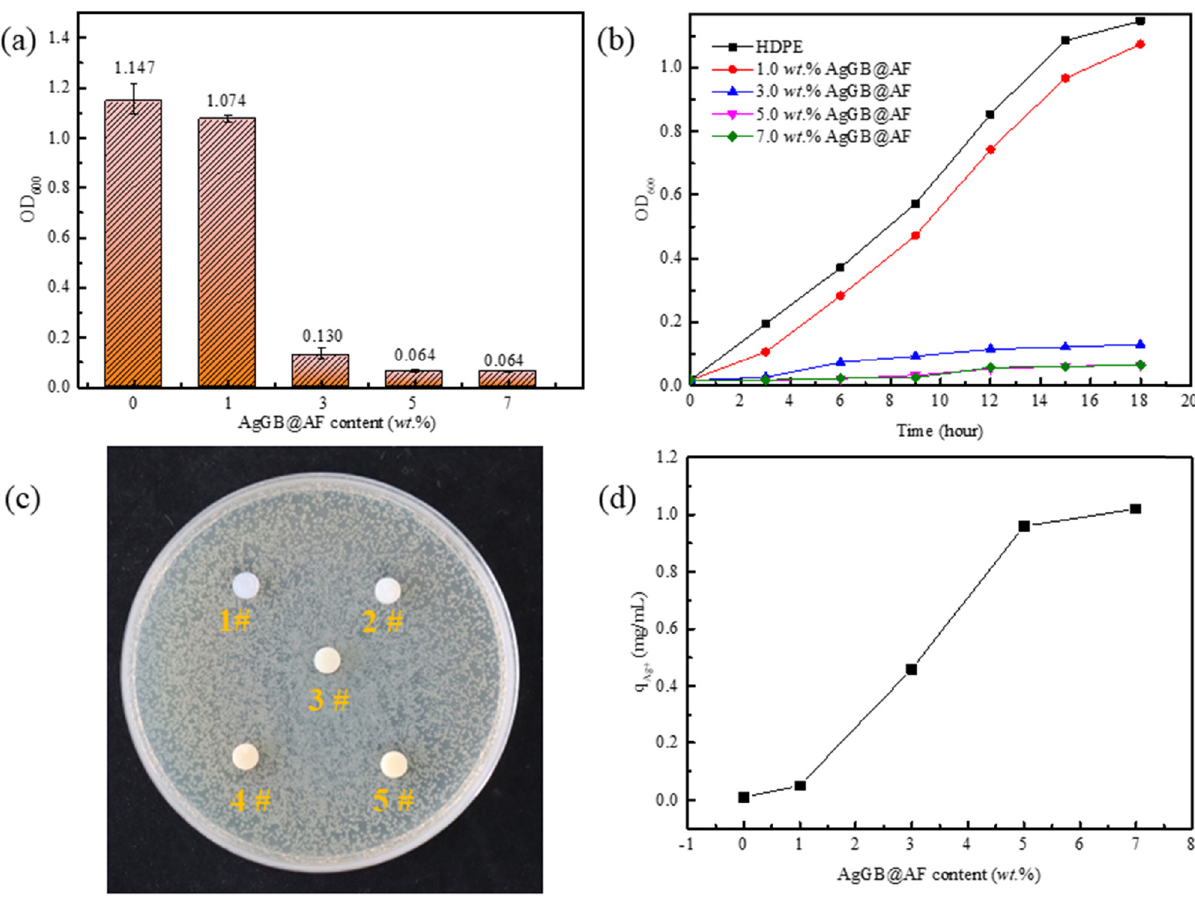
Figure 8: ( a ) OD 600 values after 18 h, ( b ) OD 600 curves, ( c ) photos of inhibition ring, and ( d ) Ag ion concertation of various HDPE